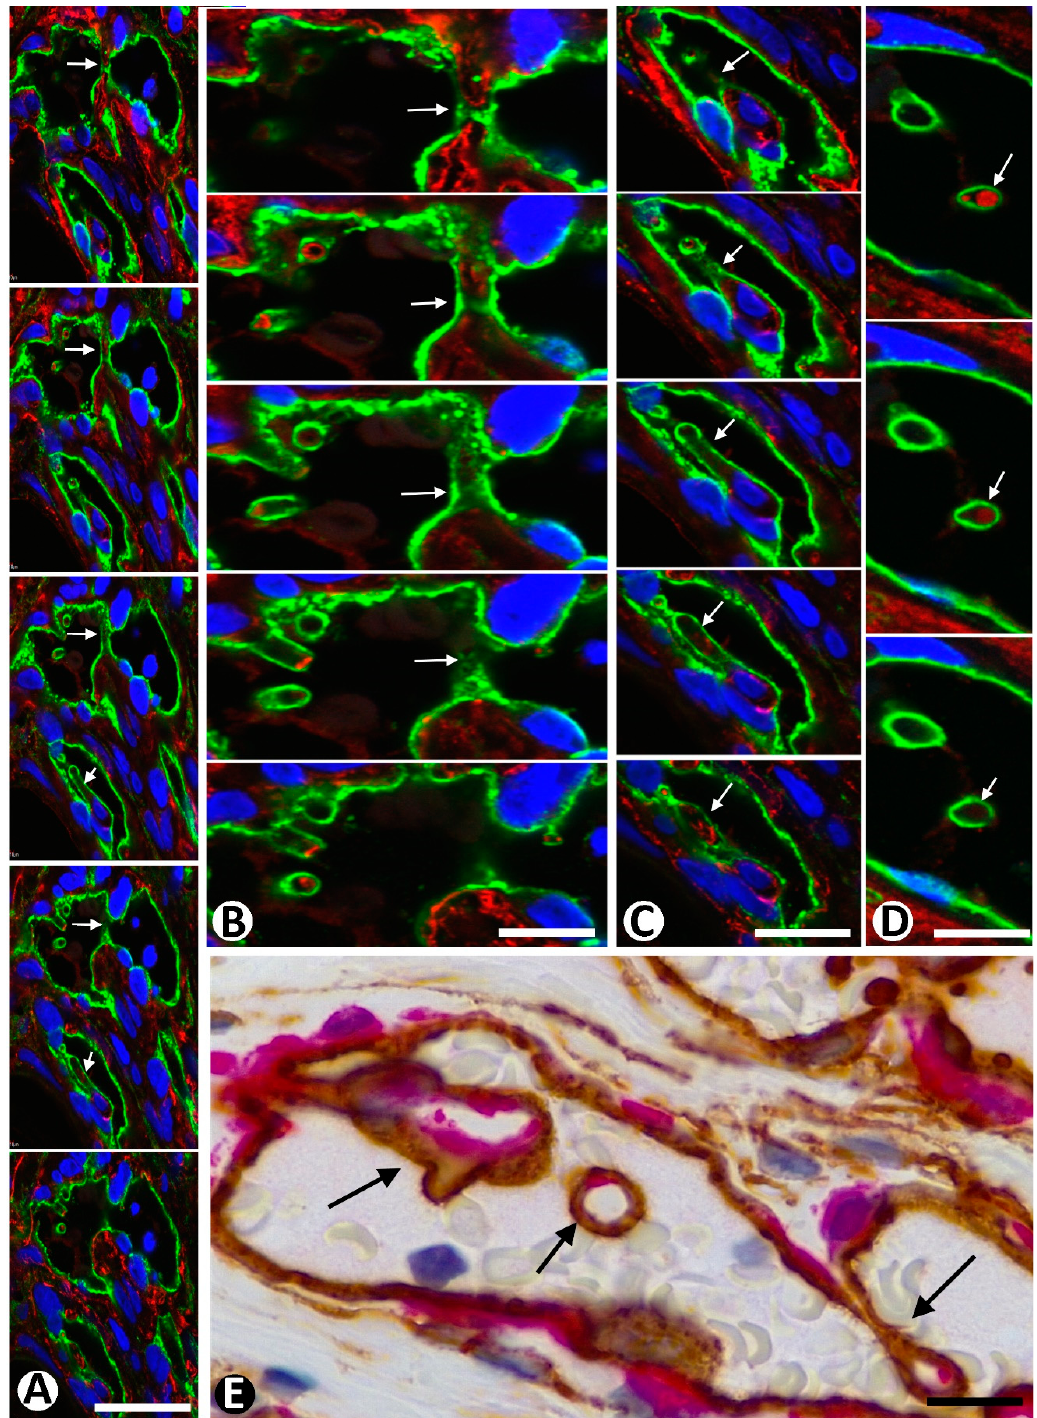
Figure 9. ( A – C ): Several intravascular pillars (arrows), which appear and disappear in sequential views, are shown in confocal microscopy in A, and details of some in ( B , C ). ( D ): Sequential views of cross-sectioned pillars in confocal microscopy (arrows). Note the cover of pillars formed by endothelial cells (green) and the presence in the core of some pillars of collagen IV (red). ( E ): Intravascular pillars (arrows), observed by immunochemistry, showing endothelial cells (brown) forming the pillar cover and pericytes (red) in the pillar core. ( A , D ): Double immunofluorescence labeling for CD34 (green) and anti-collagen IV (red) in sequential views in confocal microscopy. ( E ): Double immunochemistry for CD34 (brown) and α SMA (red). Bar: ( A – D ): 10 µm; ( E ): 15 µm.